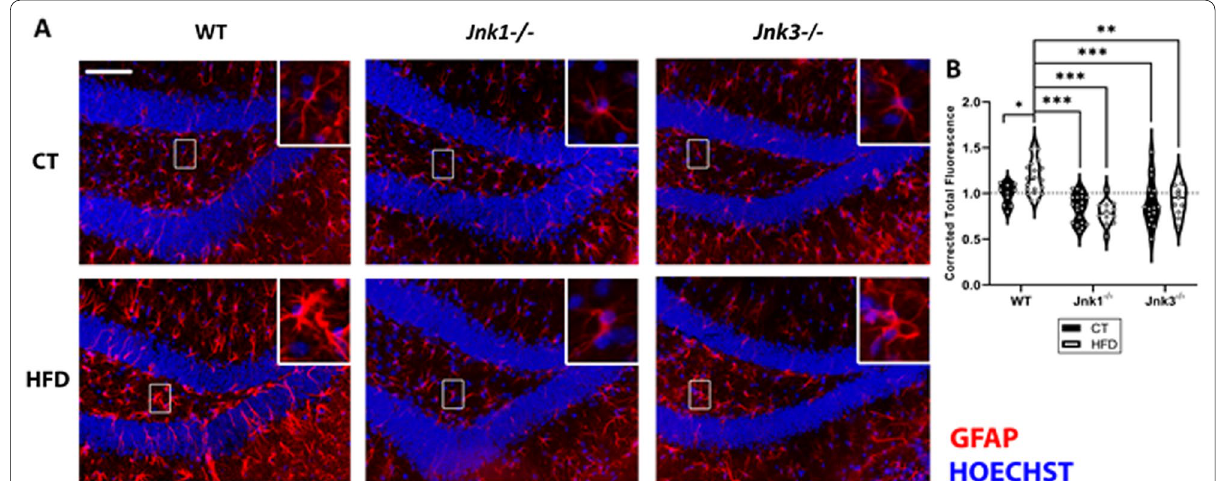
Fig. 7 A Representative images of GFAP‑labeling (red) in the dentate gyrus of the hippocampus. Hoechst was used to stain the nuclei (blue). Scale bar: 100 µm (n 15). B Calculation of differences in fluorescence intensity for GFAP. Relative intensity quantification numbers were obtained under ≥ the following formula: CTCF (Corrected Total Cell Fluorescence) Integrated Density (Area of selected cell X Mean fluorescence of background = − readings). Differences between groups were analyzed using ANOVA and Tukey’s. Significance was represented as follows: *p < 0.05, **p < 0.01 and ***p < 0.001 (n 4/experimental =